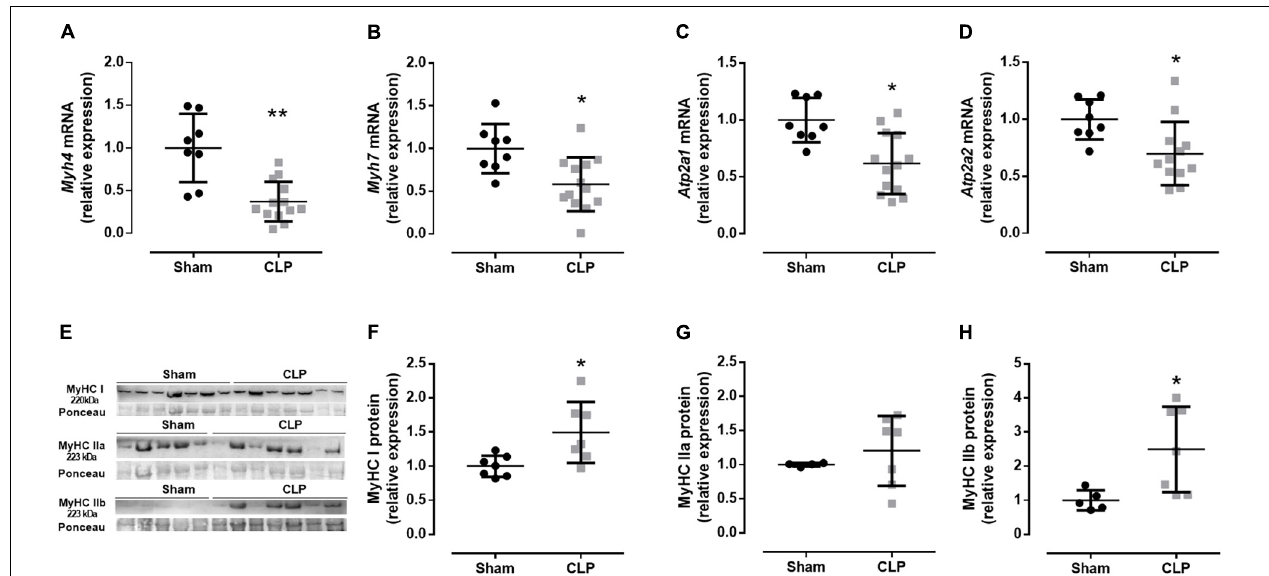
FIGURE 3 | Moderate sepsis modulates fiber profile. mRNA expression of Myh4 (encodes MHC IIb expressed in fast-glycolytic type II fiber; A ), Myh7 (encodes MHC I expressed in slow-oxidative type I fiber; B ), Atp2a1 (encodes SERCA1 expressed in fast-glycolytic type II fiber; C ), and Atp2a2 (encodes SERCA2 expressed in slow-oxidative type I fiber; D ) in the diaphragm. Western blot representative figure for measuring MyHC I (fiber type I marker), MyHC IIa (fiber type IIa marker), and MyHC IIb (fiber type IIb marker; E ). Relative protein expression of MyHC I (F) , MyHC IIa (G) , and MyHC IIb (H) . Black dots represent sham animals caused by surgical stress, and gray squares represent CLP – cecal ligation puncture technique. Values are expressed as mean ± SD, * p < 0.05, and ** p < 0.005 compared with the sham